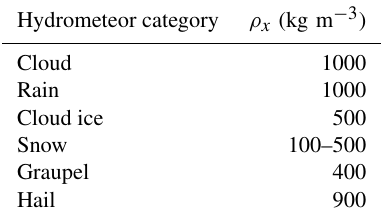
Table 1. Bulk density for each hydrometeor